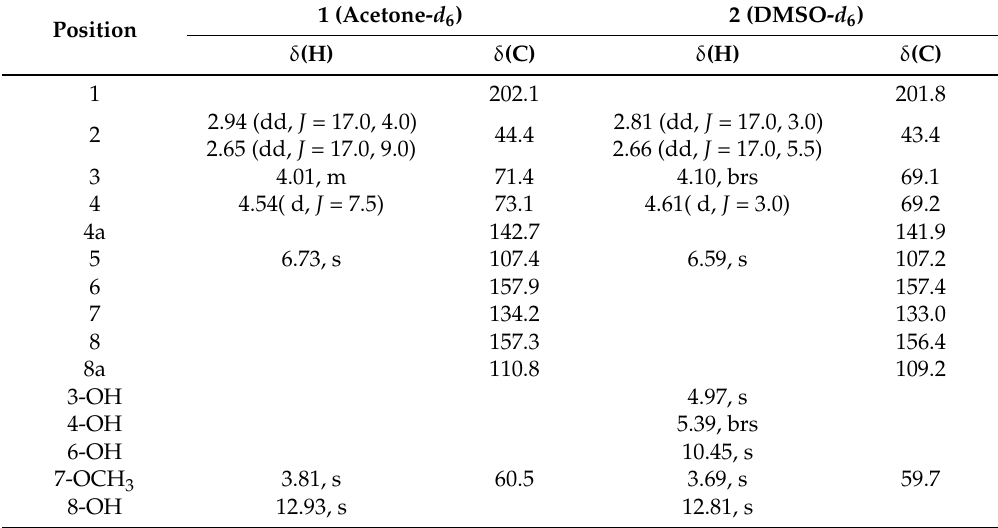
Table 1. 1 H- and 13 C-NMR Data (500 and 125 MHz, resp. δ in ppm, J in Hz) of compounds 1 and 2